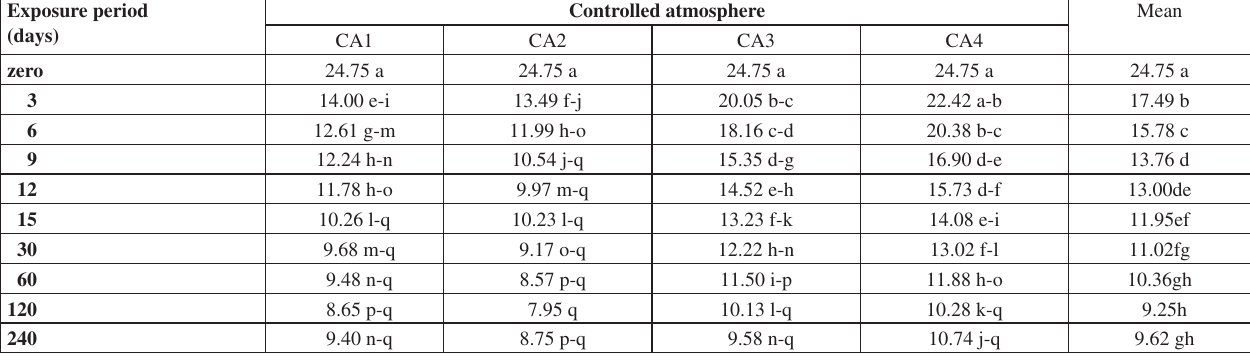
Table 5: Effect of exposure periods and different controlled atmospheres on malondialdehyde content of onion seeds stored for 12 months Exposure period